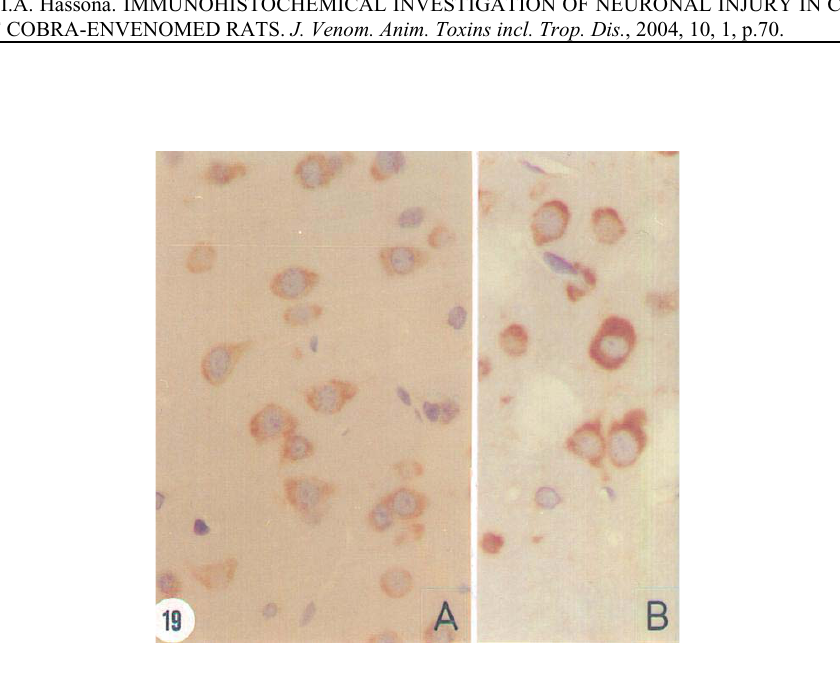
Figure 19 . Low Bcl-2 immunoexpression 48 hr after high dose envenoming (Figure A). Note cells with intense reactivity (Figure B). (X400)